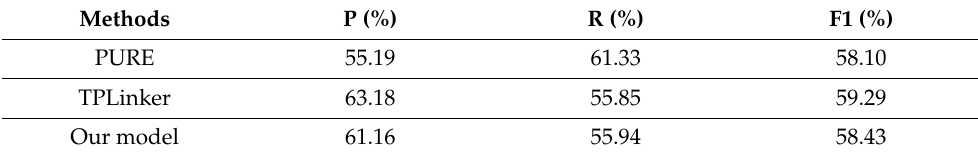
Table 7. The comparison between our model and recent SOTA models on CMeIE.